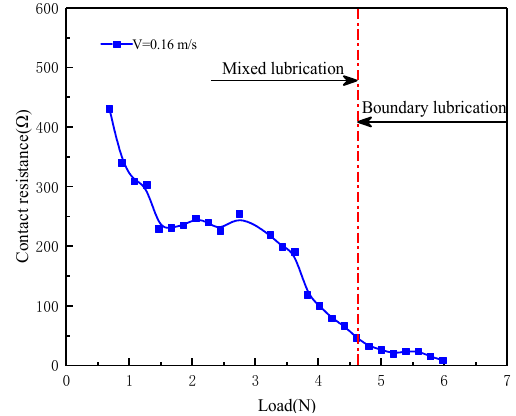
Figure 3. Variation of contact resistance with load.